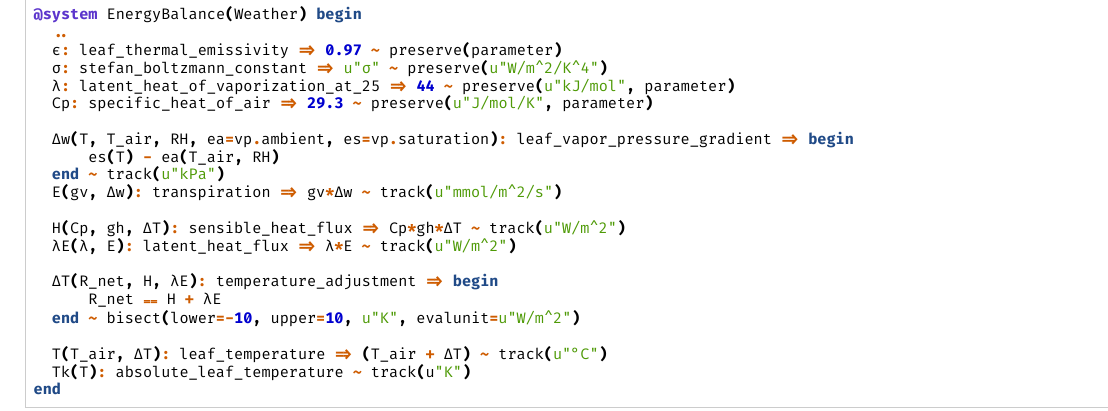
Figure A2. Snippet of model code implementing energy balance process.